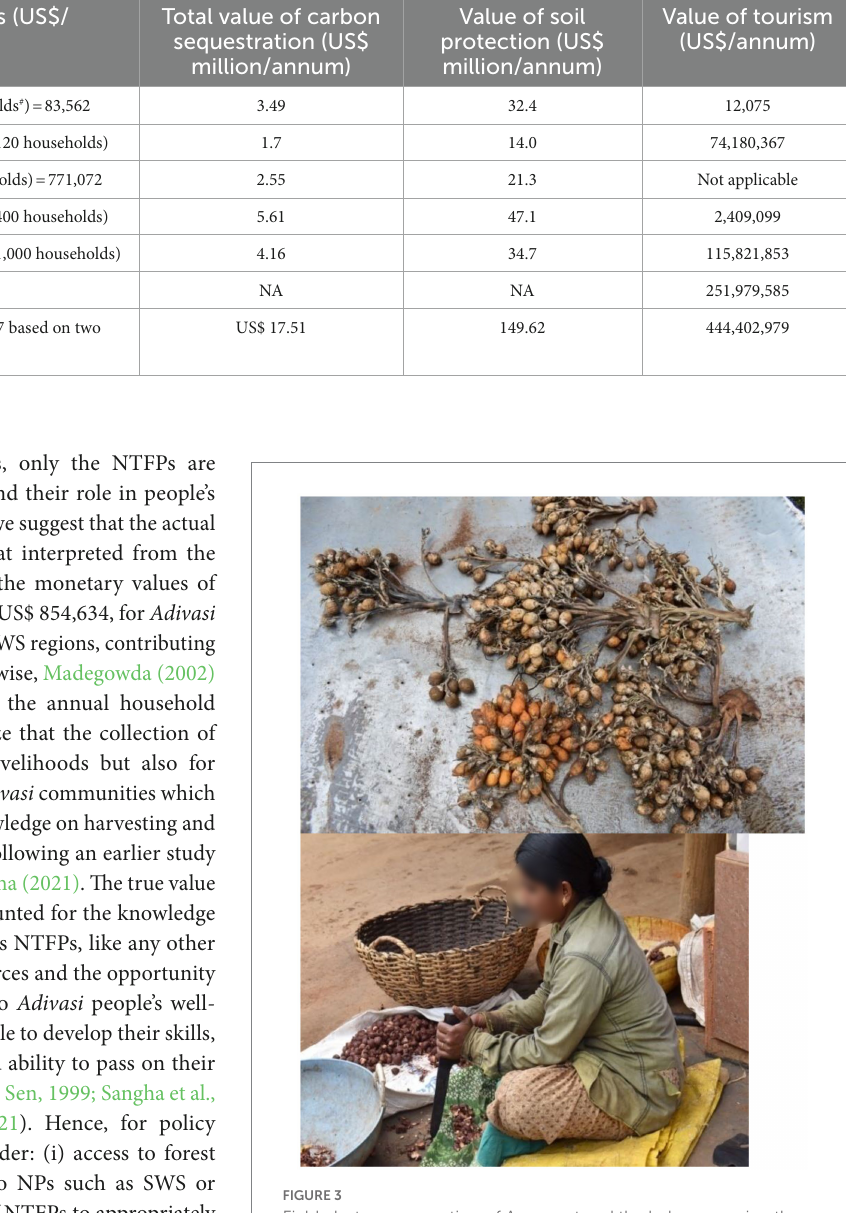
TABLE 6 Summary of various ES delivered from protected areas in the Western Ghats. Name of protected areas